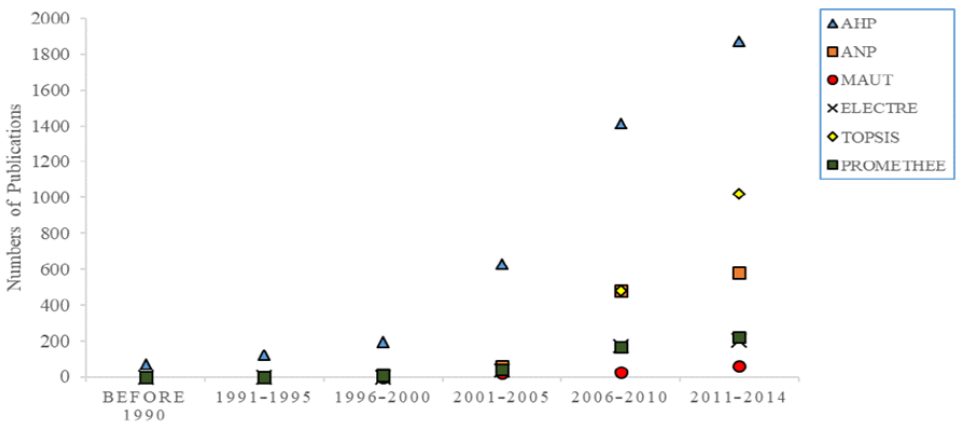
Figure 1. Multi-criteria decision making methods used in 1990–2014.